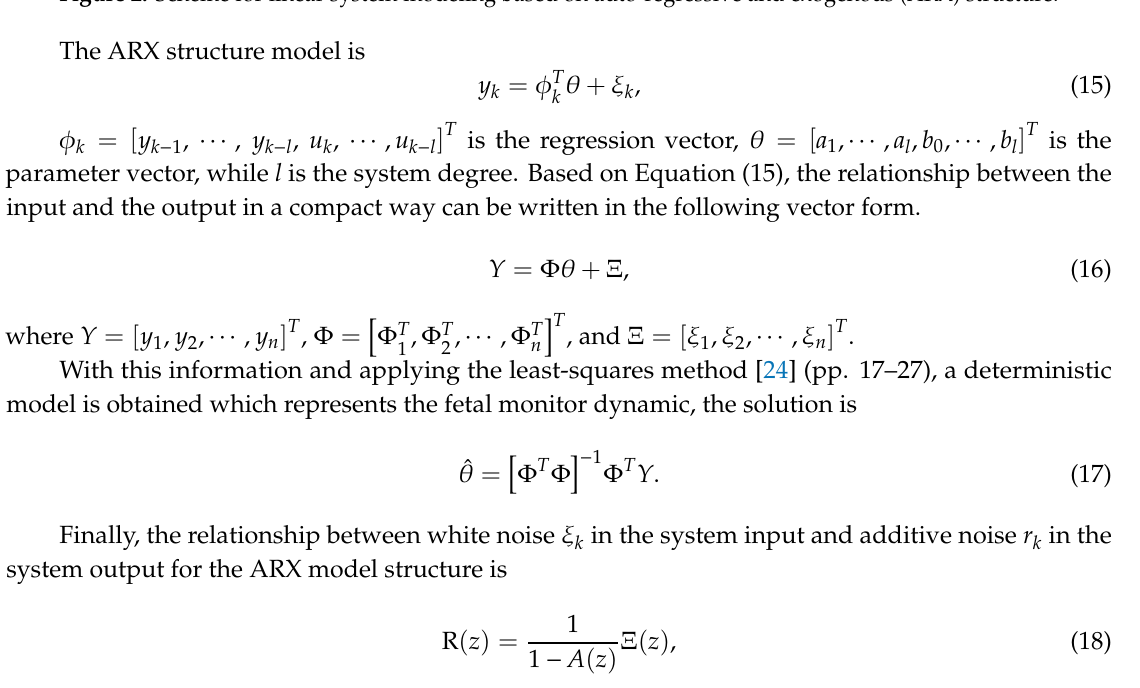
Figure 3. Estimation process of the error distribution function (cid:1832) (cid:2950)